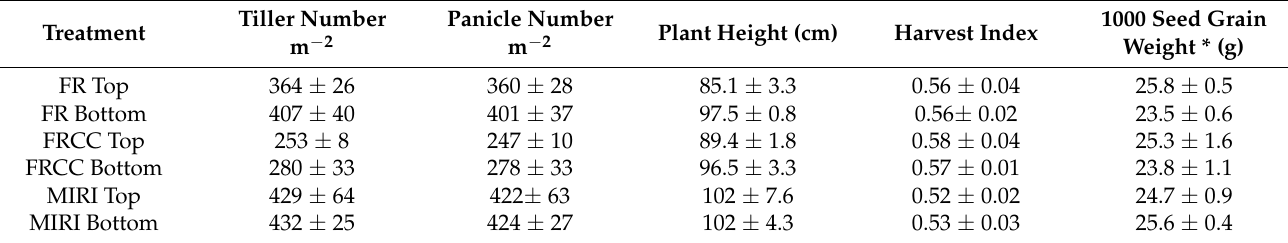
Table 3. Various yield components of rice from top and bottom sections of furrow rice (FR), furrow rice with cover crops (FRCC) and multiple inlet rice irrigation (MIRI). Data shown are average ± standard error ( n = 3).